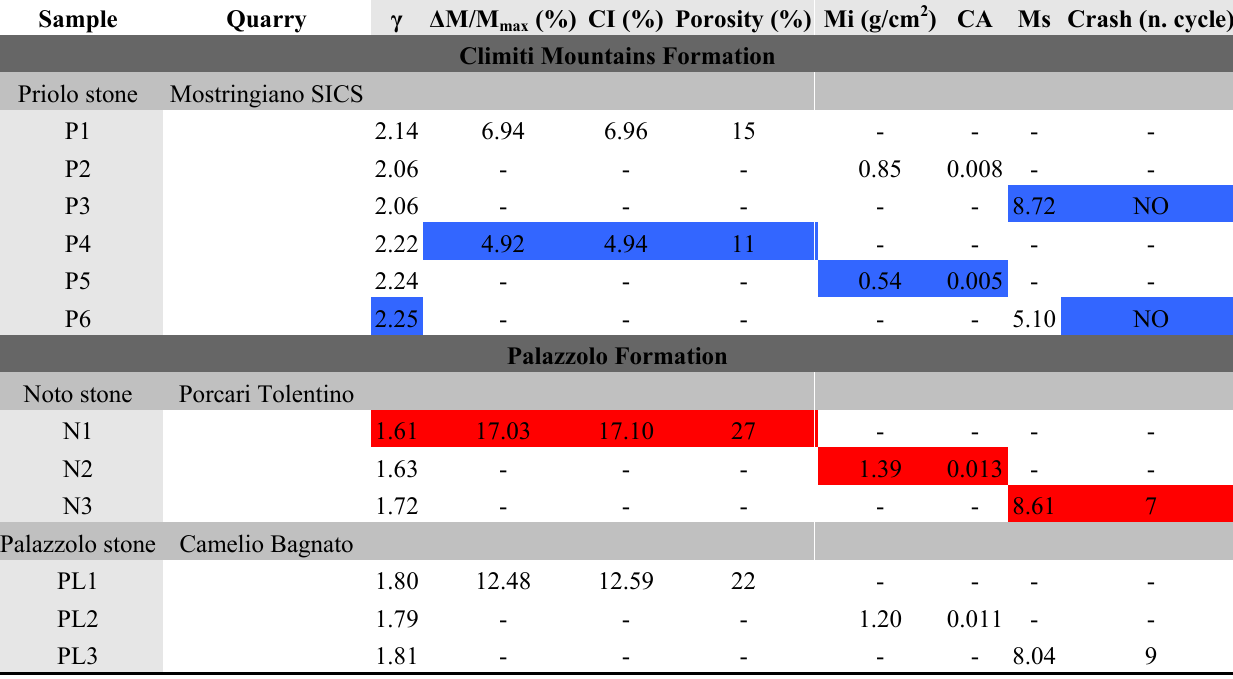
Table 4. Summary table of the physic analysis on quarry